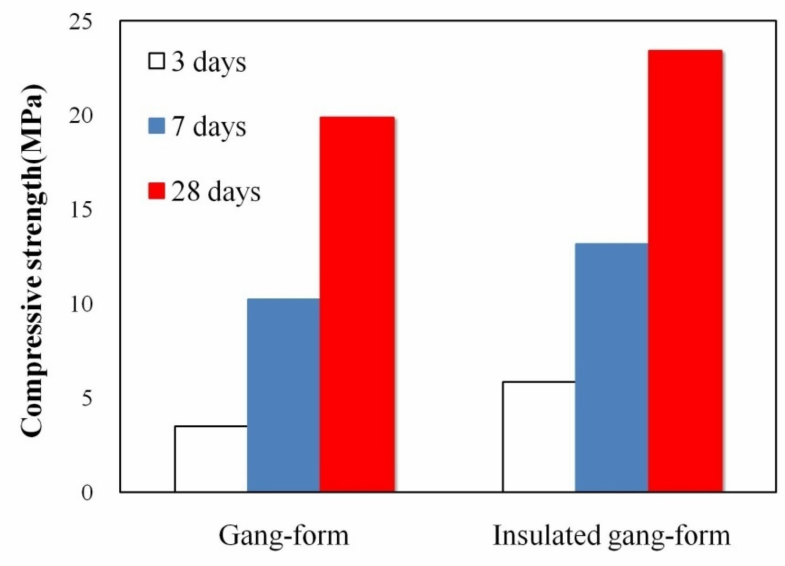
Figure 9. Compressive strength characteristics of